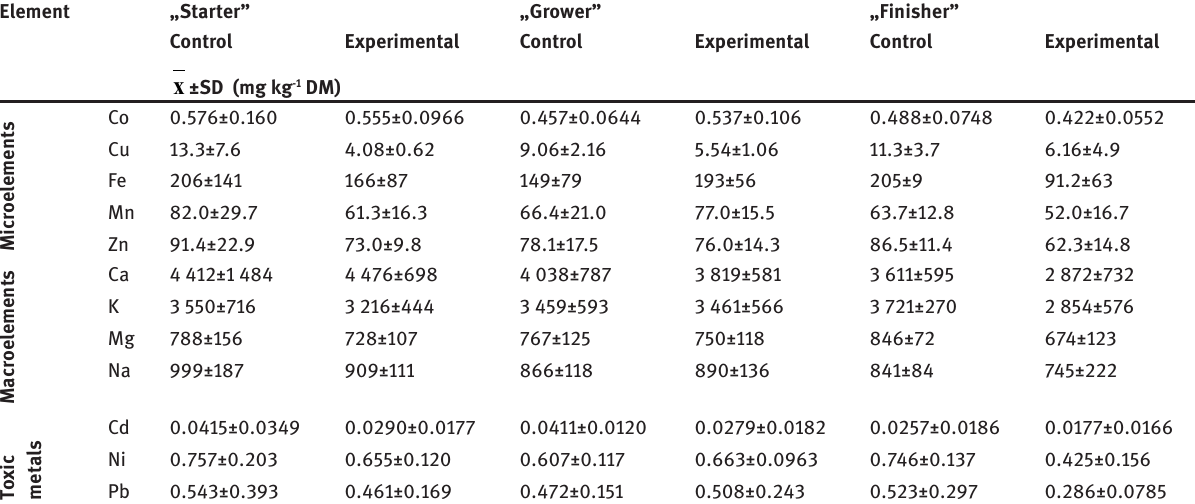
Tabele 4: The mineral composition of the feed for pigs in the control and experimental group.